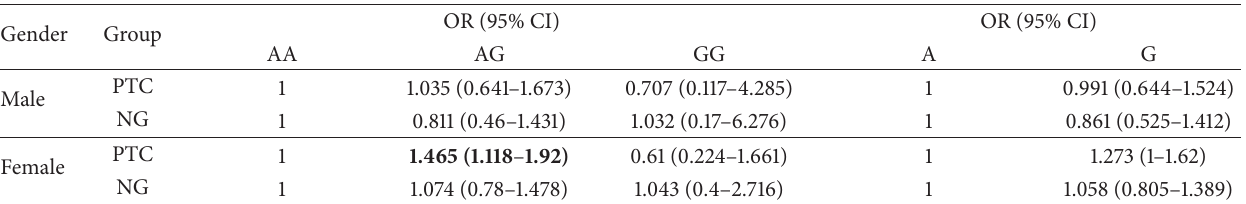
Table 3: Associations between the genotypes of MET SNP (rs1621) and risk of PTC in male and female patients.